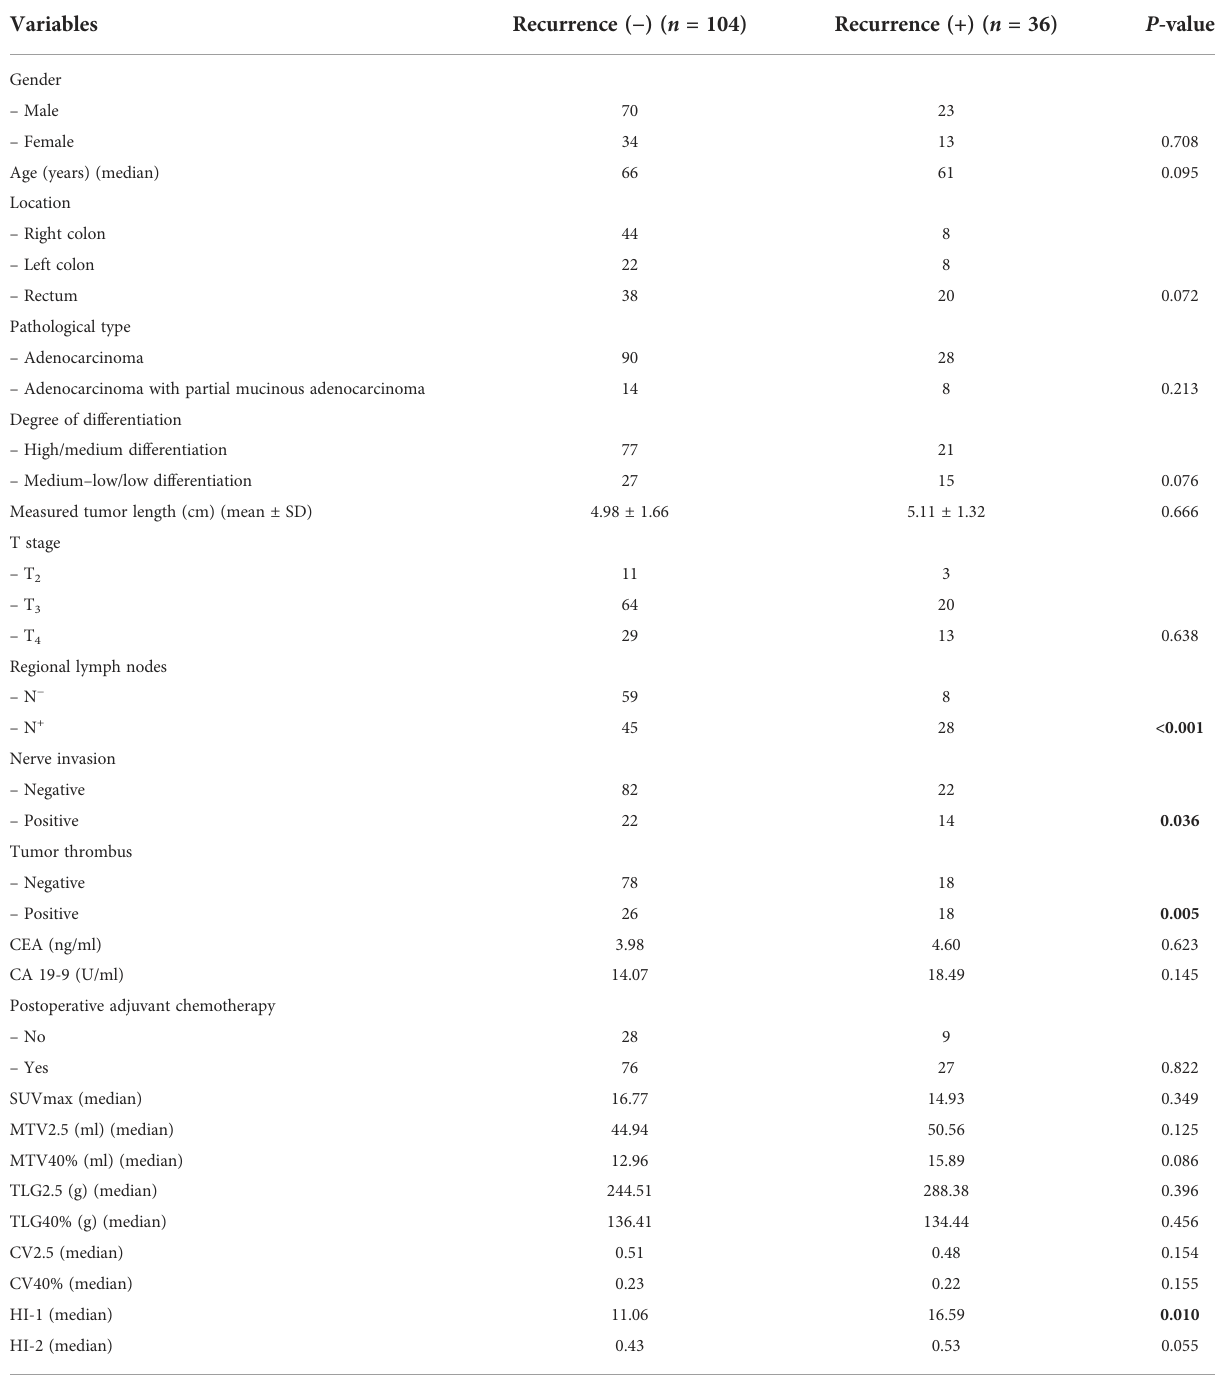
TABLE 4 Comparison of characteristics and PET parameters according to colorectal cancer recurrence after radical